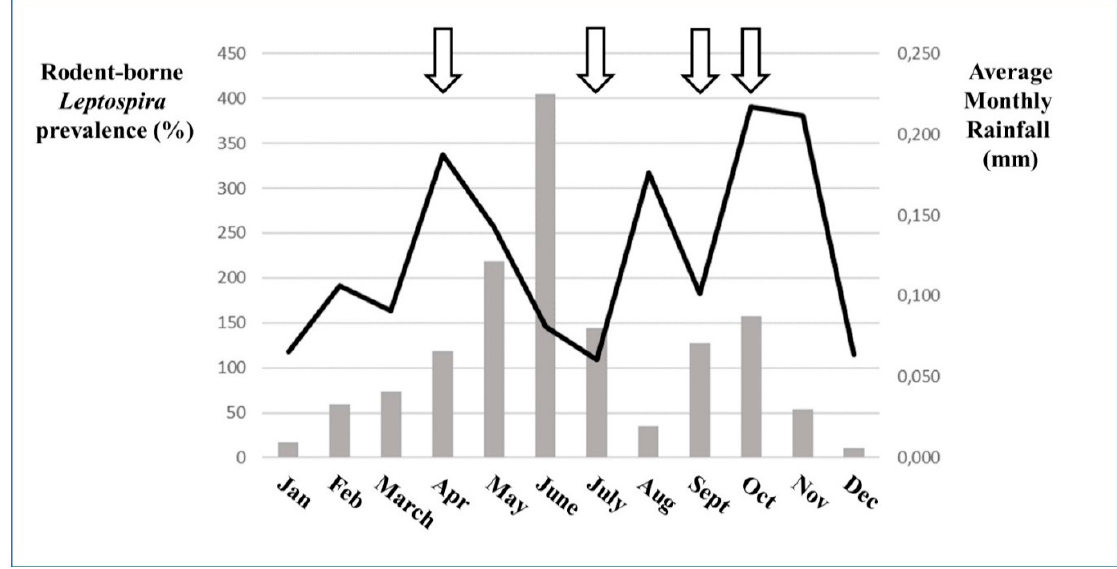
Figure 4. Temporal variations of rodent-borne Leptospira prevalence (gray histograms) and average monthly rainfall (black line, calculated for the 2009–2015 period) as compiled from our whole dataset (four trapping zones, 2006–2016 period; see text for details). Arrows indicate average monthly rainfall between 100 and 200 mm.